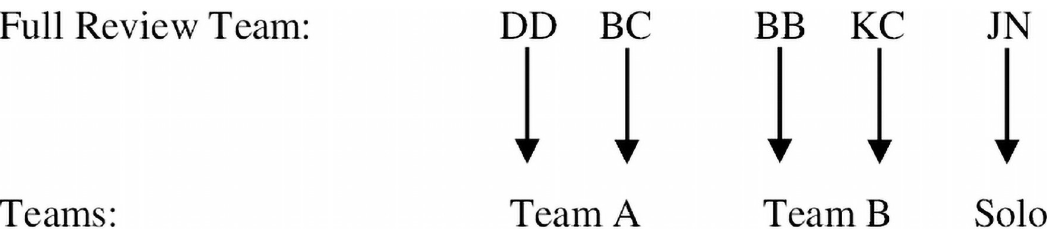
Fig 1. The full review team was divided into smaller teams to search the